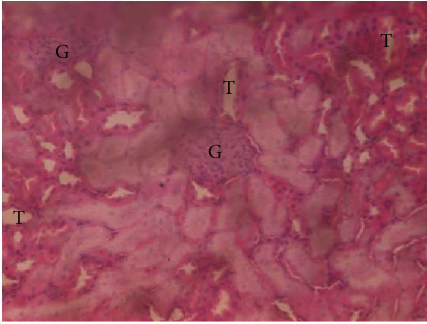
Figure 8: Photomicrographs of the group II rats showing normal kidney.